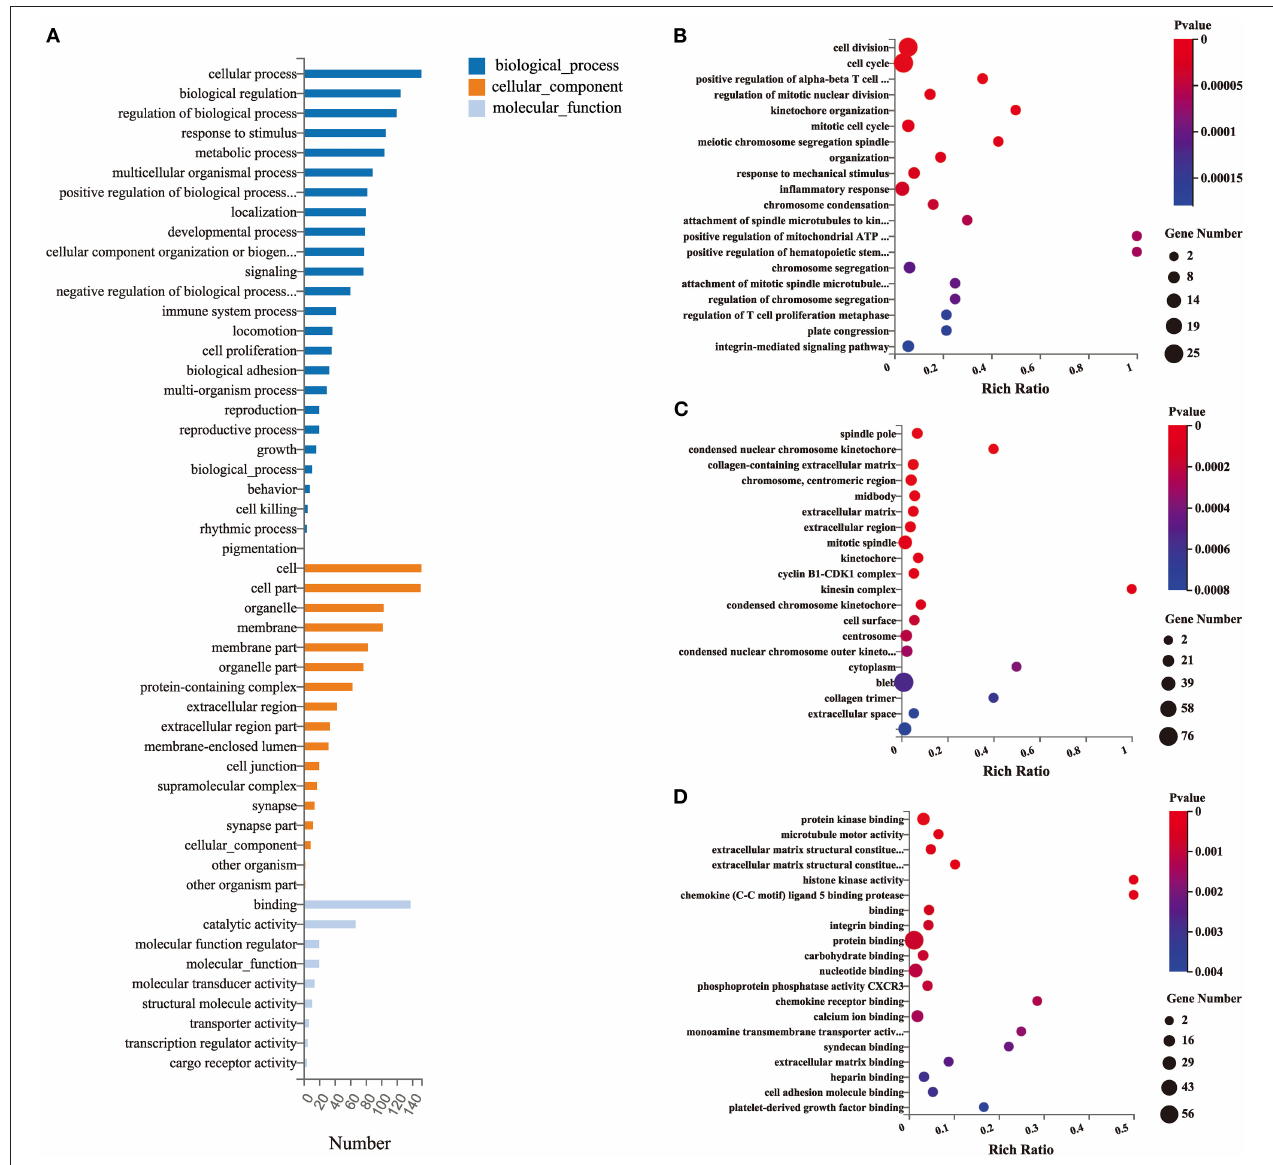
FIGURE 3 | Gene ontology (GO) functional enrichment analysis of DEGs. (A) Classification of GO functional enrichment terms. (B–D) Bubble plots showing the top 20 significant biological processes, cellular components, and molecular functions of DEGs. Each bubble with varied color represents different p -value. n = 3